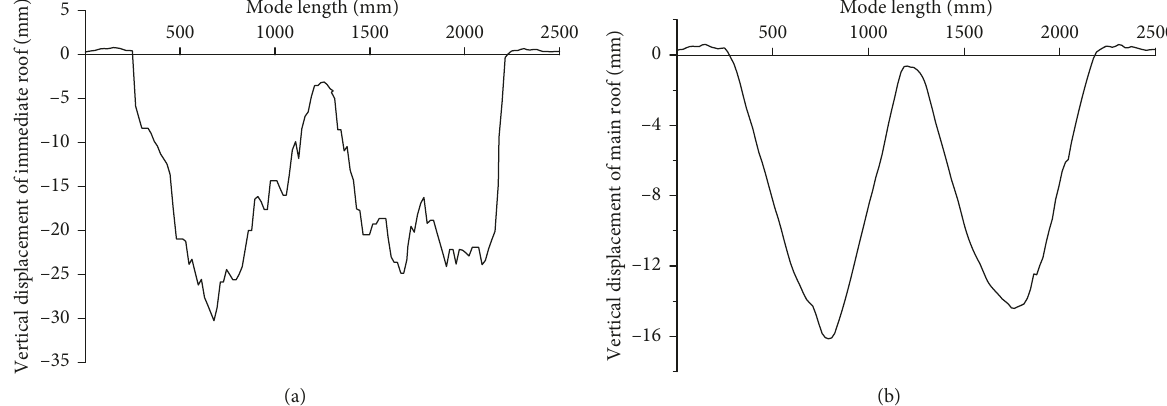
Figure 13(c). Regarding the stress of the 11215 working face, the closer the distance to the 11213 working face was, the higher the stress of the main roof was, for which, the